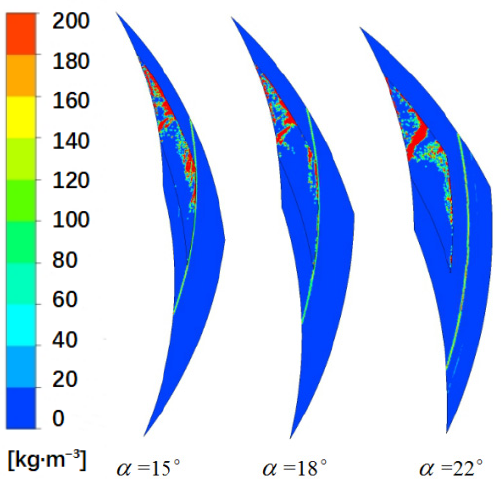
Figure 10. Particles’ distribution with different spiral angle.